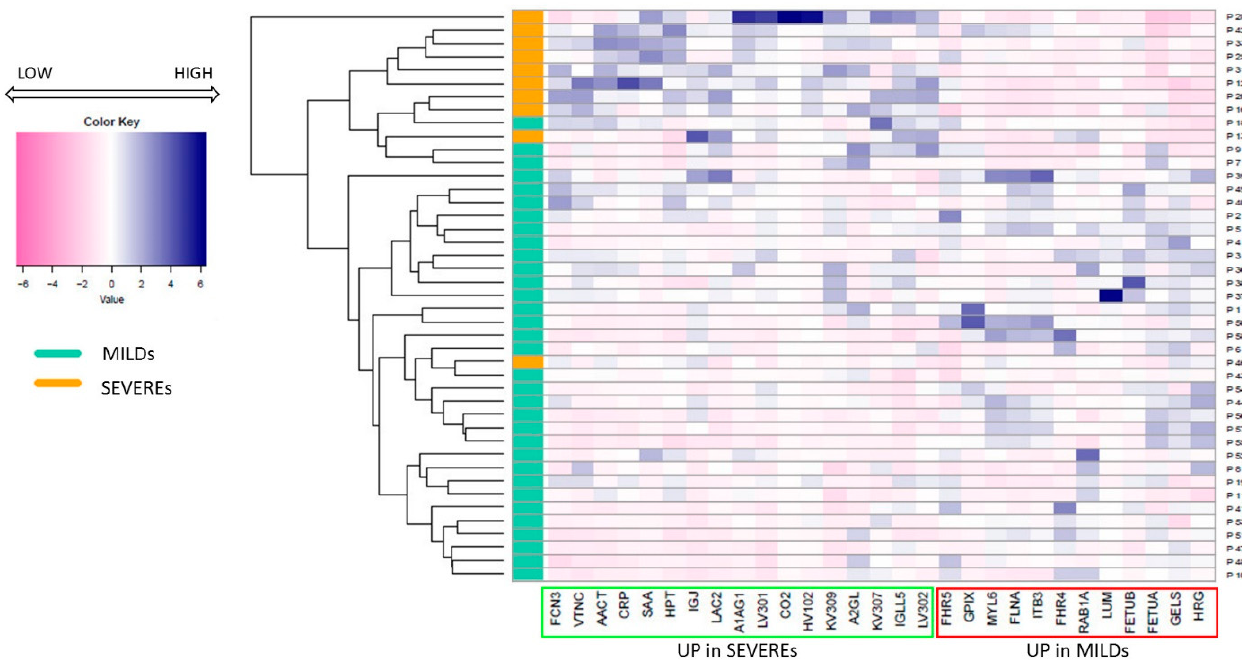
Figure 2. Heatmap-cluster analysis. The heatmap shows the different protein expression levels in correlation to each patient (reported as proteomic IDs). The green box highlights the proteins that are up-expressed in Severe patients, while proteins up-expressed in Mild patients are highlighted by a red box; it can be observed that the two groups of proteins differentially clusterise. Patients belonging to the MILDs group are shown in aquamarine, while SEVEREs are shown in orange; the colour scale from pink to blue indicates the level of expression of each protein, from a low expression to a high expression.